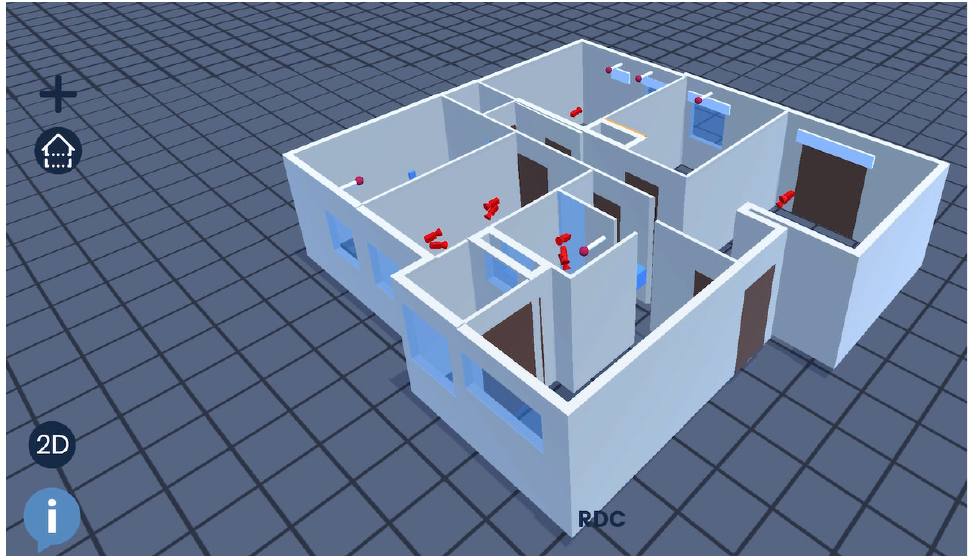
Figure 4. The image on the 3D model of the sample apartment with all divisions, objects, photos, and annotations (screen shot from BIMeo software)